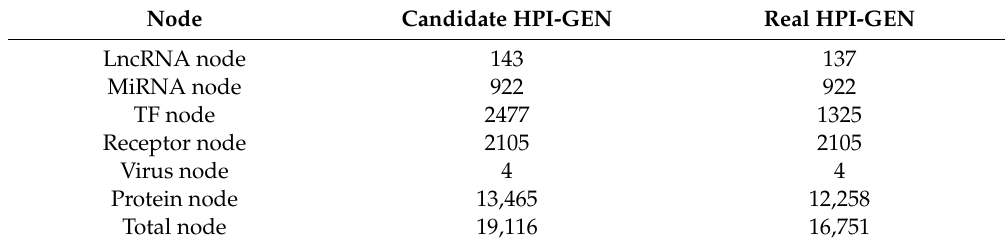
Table 1. The total number of nodes in candidate interspecies host / pathogen interspecies genetic and epigenetic interaction network (HPI-GEN) and identified HPI-GEN during Hepatitis B Virus (HBV) infection.